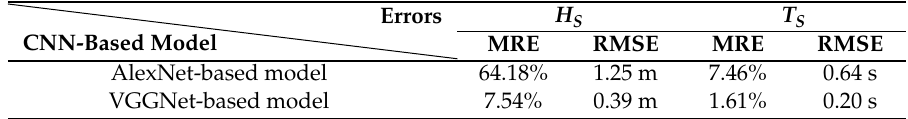
Table 7. Inversion errors of wave’s spectral peak period ( T S ) and significant wave height ( H S ) by CNN-based